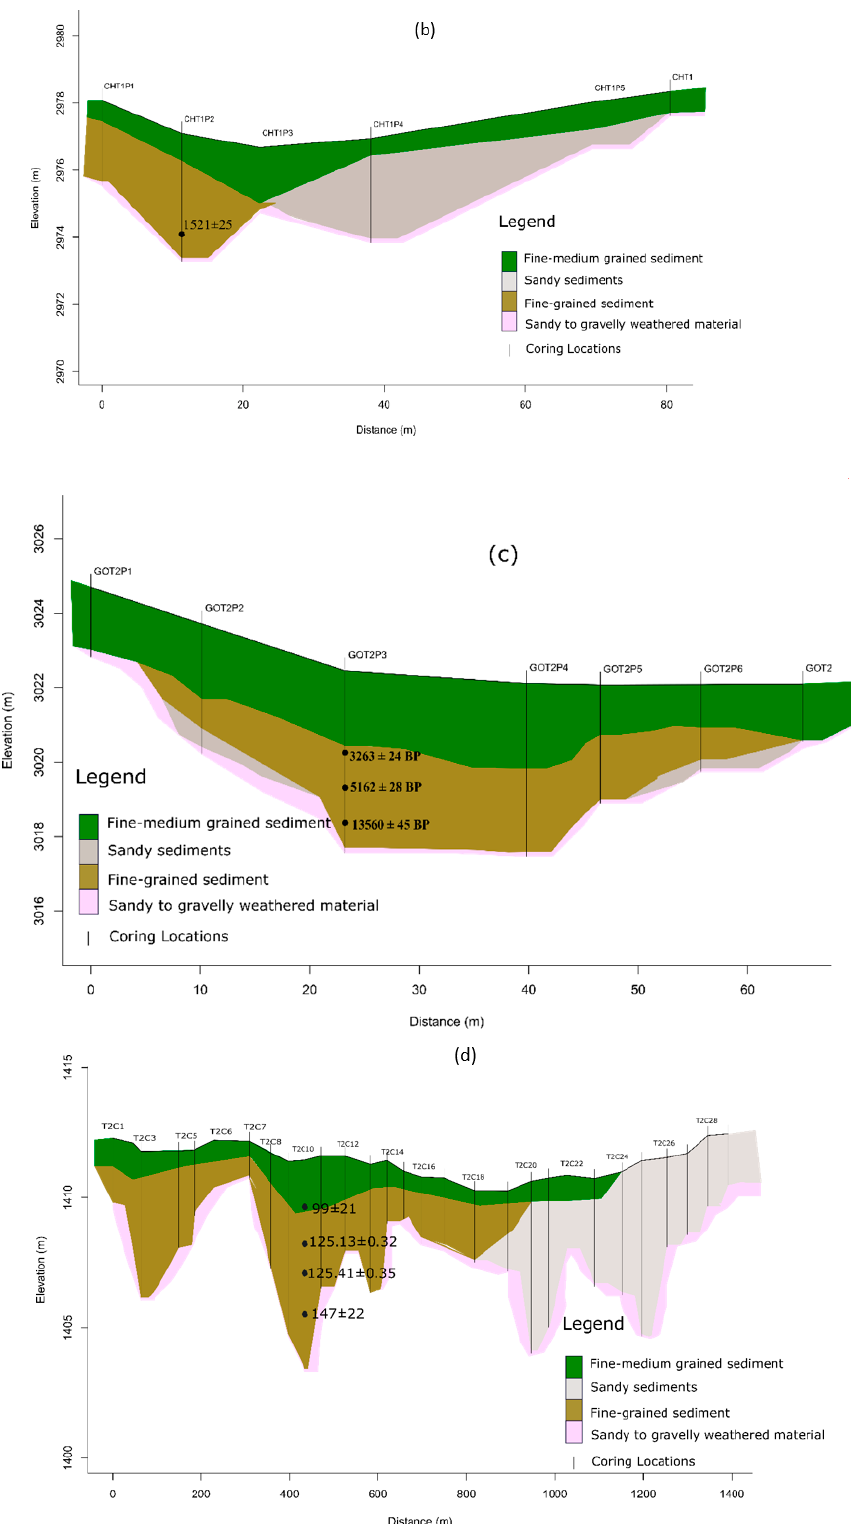
Figure A1. Typical cross-section with indication of the various sedimentary units in the ( a – c ) Chencha floodplain ( d ) Dembelle floodplain.